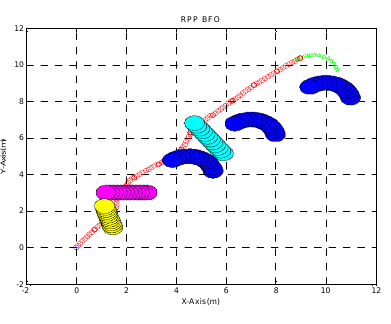
Fig. 15: 3rd scenario pathfor